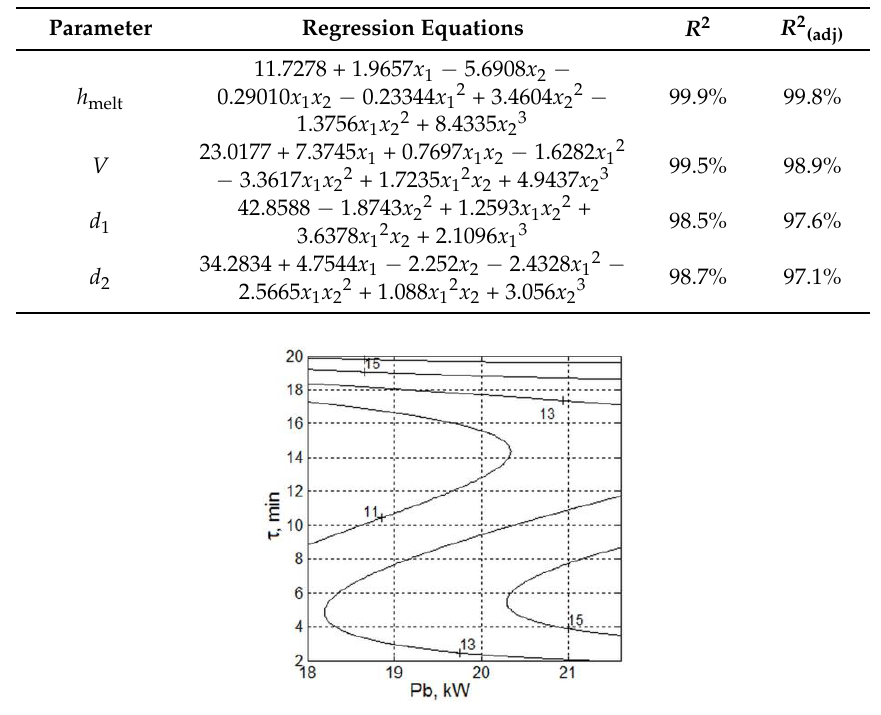
Figure 4. Contour plot of the molten pool height h melt depending on the beam power P b and the melting time τ.